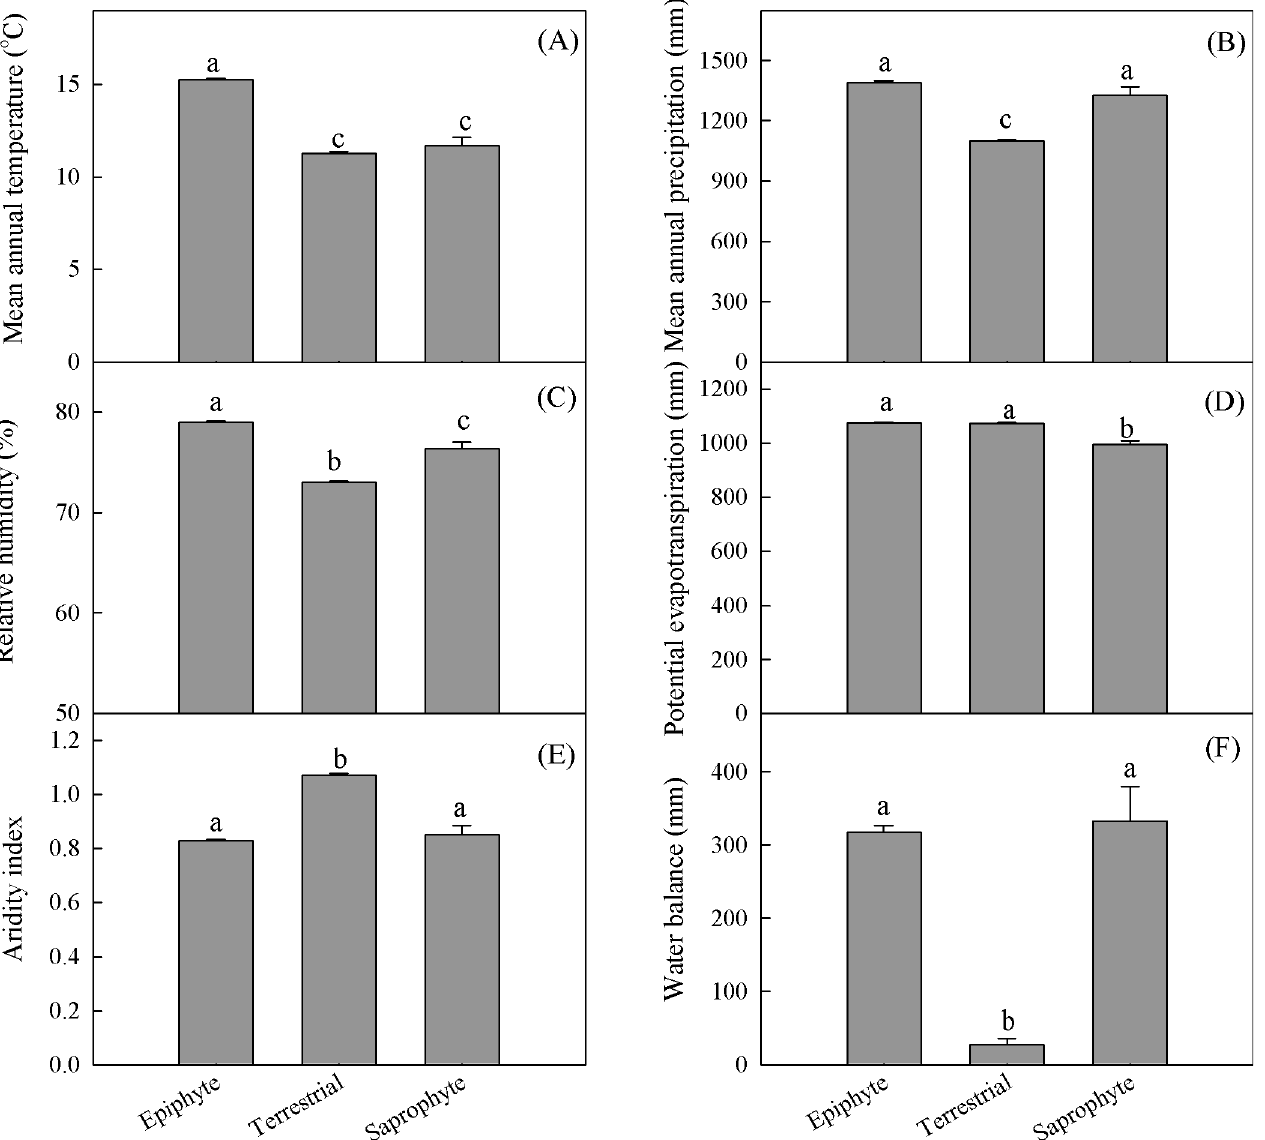
Fig 7. Differences in mean annual temperature (A), mean annual precipitation (B), relative humidity (C), potential evapotranspiration (D), aridity index (E), and water balance (F) associated with epiphytic, terrestrial, and saprophytic orchids. Different letters in each panel indicate significant differences among life forms at P <